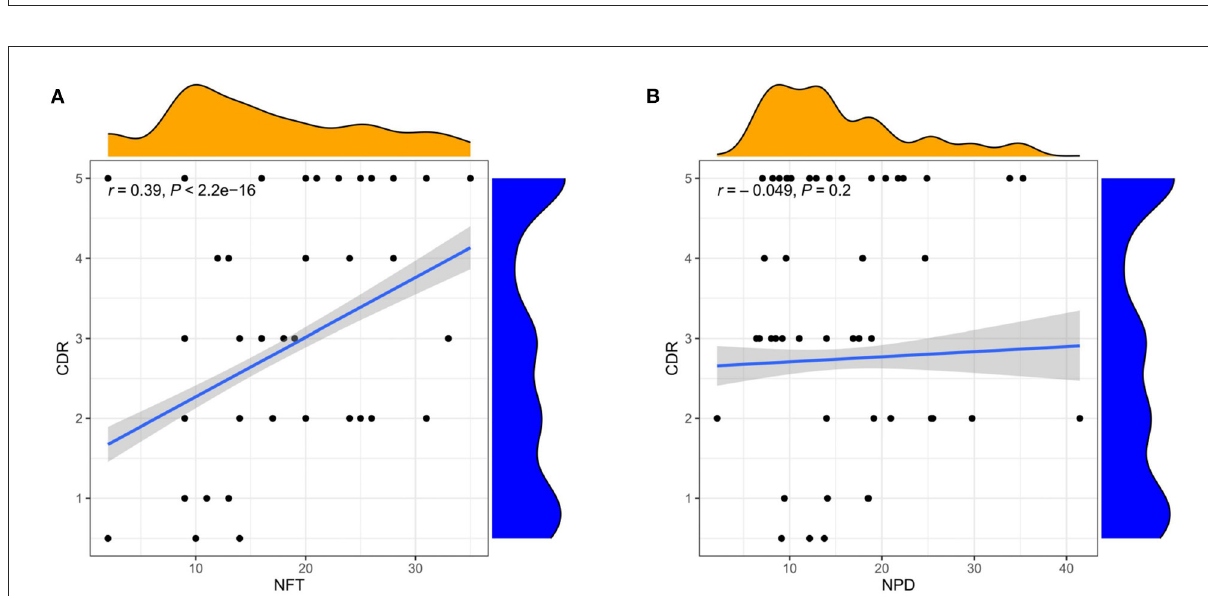
FIGURE6 Correlation analysis of clinical features. (A) Correlation between CDR and NFT. (B) Correlation between CDR and NPD. Spearman correlation coefficient. n = 1,146.